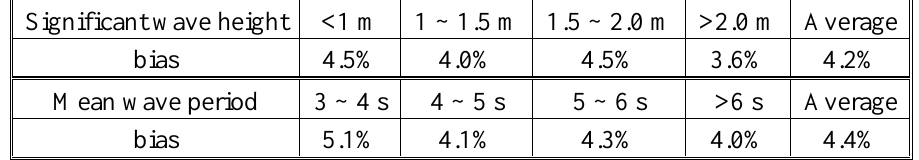
Table 2. Quantitative errors of GPS-derived wave parameters under various sea